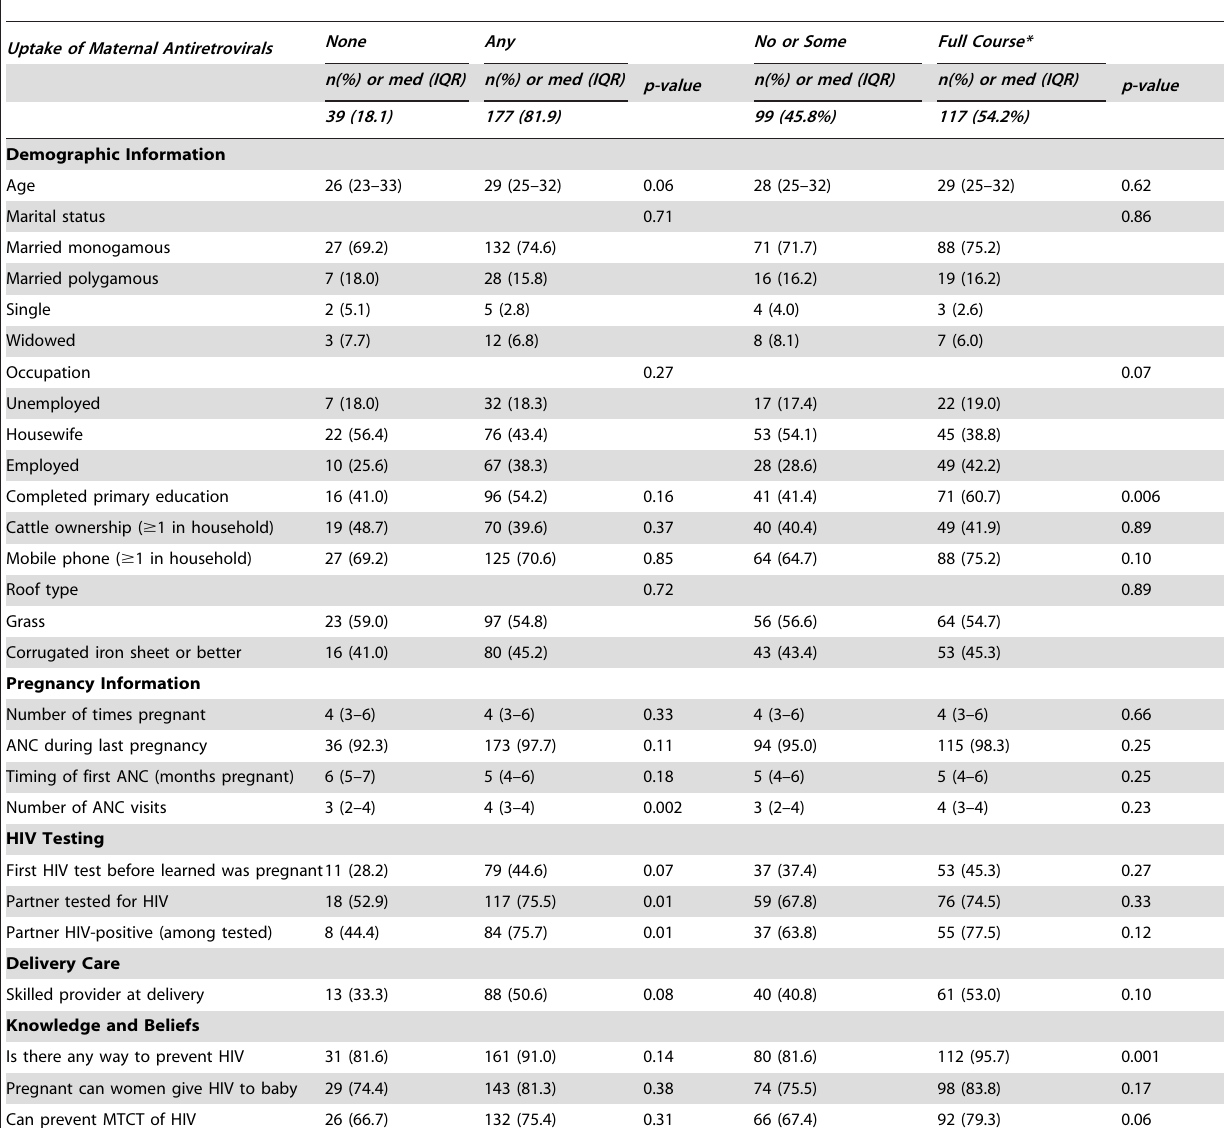
Table 3. Reported uptake of maternal antiretrovirals among HIV-positive women.